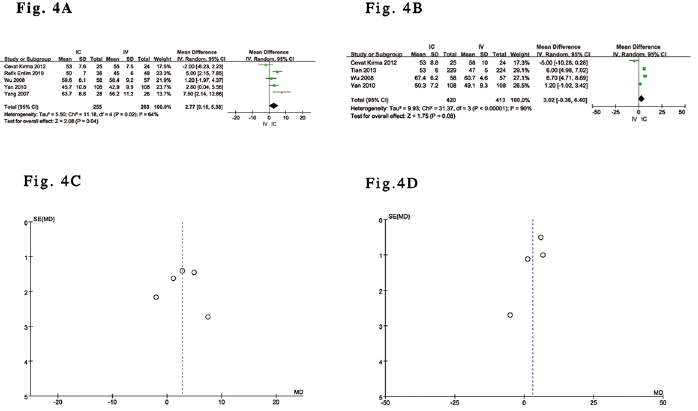
Fig 4. Forest plot of LVEF in ACS patients with IC vs. IV administration of tirofiban. (A). Forest plot for in-hospital LVEF based on a random-effects model in ACS patients with IC vs. IV administration of tirofiban. (B). Forest plot for LVEF over a medium-term follow-up, based on a random-effects model in ACS patients with IC vs. IV administration of tirofiban. (C). Funnel plot of in-hospital LVEF used to identify evidence of publication bias. (D). Funnel plot of LVEF over a medium-term follow-up used to identify evidence of publication bias.